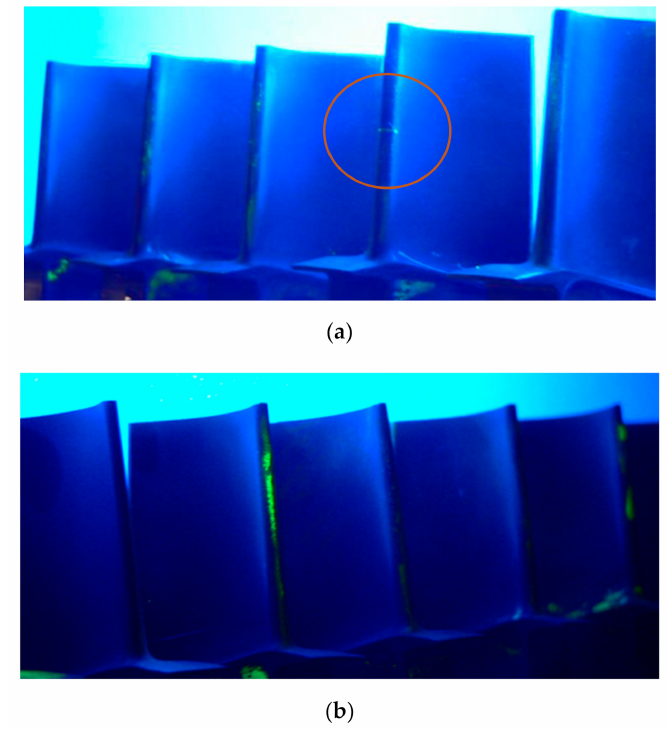
Figure 4. Fluorescent penetrant inspection (FPI) of turbine blades for series 1 (one crack) ( a ) and series 2 (no crack) ( b ).